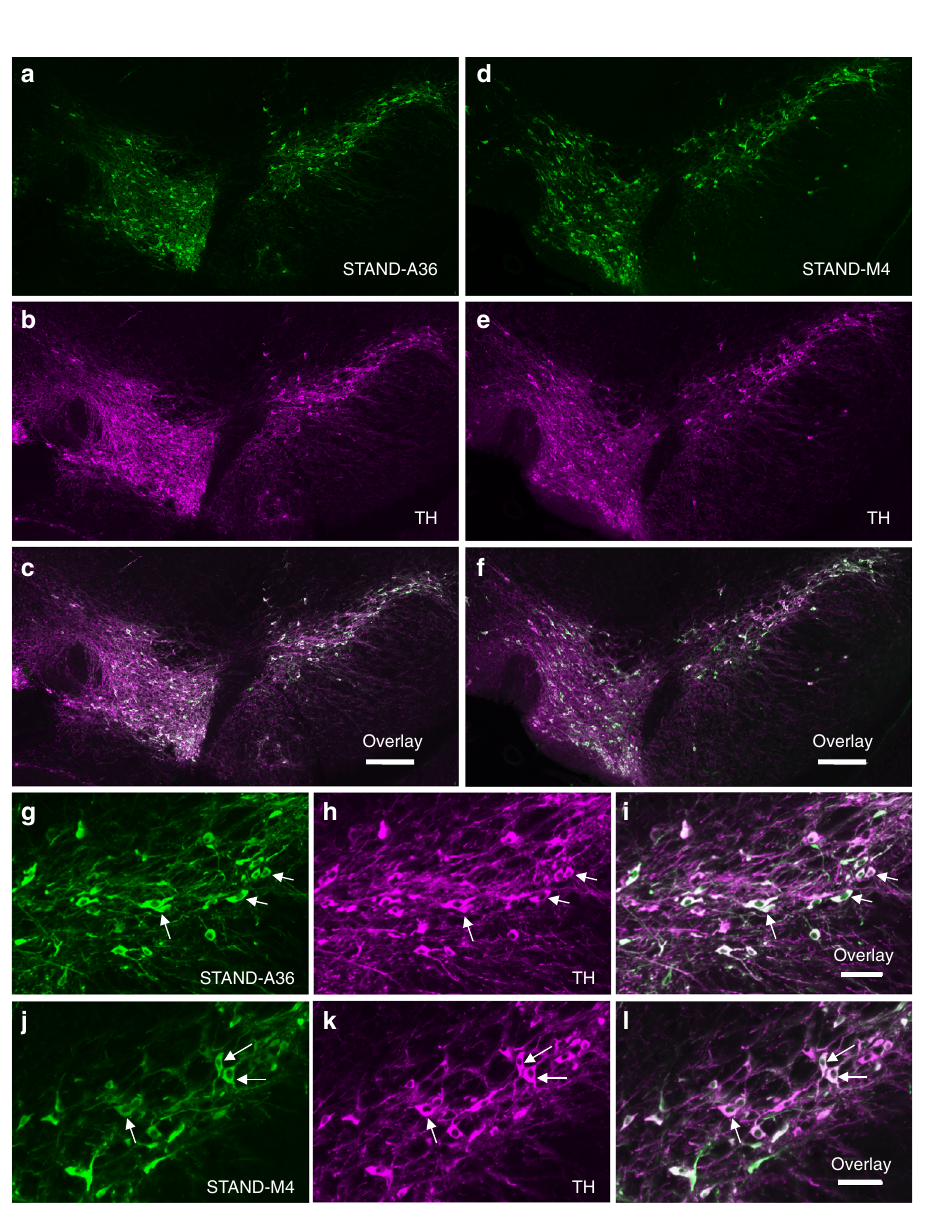
Fig. 4 Stable expression of STAND proteins in the SNc. a – l Immunohistochemical analysis of the SNc 33 days after injection with AAV9/3-STAND-A36 ( a – c , g – i ) or AAV9/3-STAND-M4 ( d – f , j – l ) a , d , g , j Anti-Flag antibody to detect scFv protein; b , e , h , k anti-tyrosine hydroxylase [TH] antibody used to detect dopaminergic neurons; c , f , i , l merged image of a and b , d and e , g and h , or j and k . g – l Magni fi ed images of the SNc region in a – c or d – f . STAND proteins were stably expressed in the cytoplasm of dopaminergic neurons (arrows). Scale bars, 200 μ m c , f and 50 μ m i , l